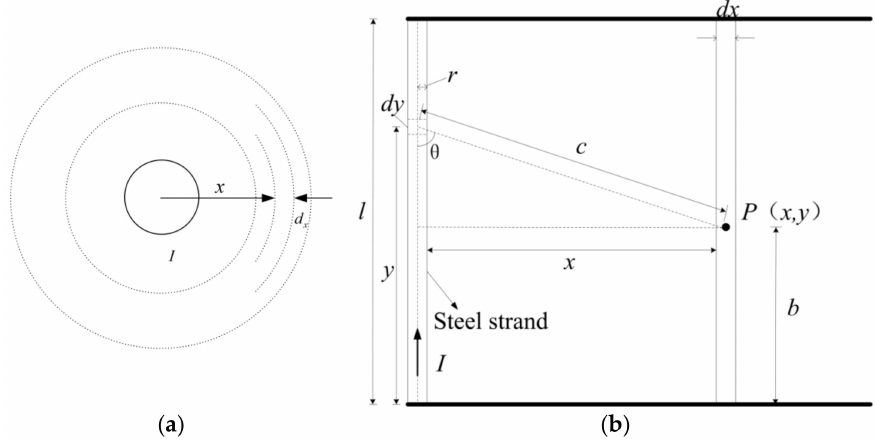
Figure 2. Calculation of external magnetic linkage of segment wire. ( a ) The distribution of external flux linkage; ( b ) Magnetic field